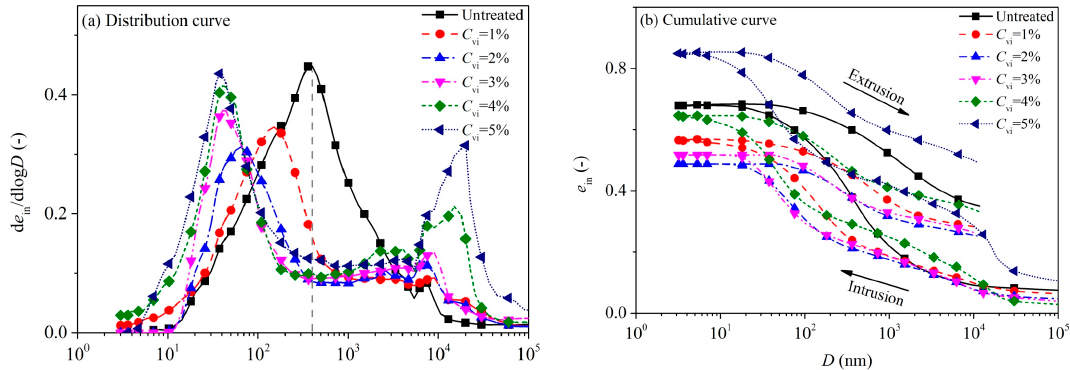
Figure 14. MIP results of saturated untreated and cement-treated GRSs cured to 28 d. The cumulative curves came from the cumulated intrusion volume of the mercury in an intru- sion–extrusion cycle multiplied by the equivalent grain density (i.e., e in = V in × ρ s ) (see Figure 14b). It was assumed that the mercury was retained in the macro-pores after the intrusion pressure was removed [32,33]. Therefore, the macro-void ratio (ratio of the volume of macro-pores to the volume of all solid particles, e M ) equals the intruded void ratio after an intrusion–extrusion cycle. In addi- tion, the maximum e in was identified and adopted as the intruded void ratio of the specimen ( e in ). The micro-void ratio (ratio of the volume of micro-pores to the volume of all solid particles, e m ) is the difference between the void ratio ( e ) of the specimen and the macro-void ratio (i.e., e m = e − e M ). As the void ratio of the specimen may change during curing, the exact micro-void ratio cannot be determined based on the initial void ratio ( e 0 ). Figure 15 illustrates the delimitation of the macro- and micro-pores for the saturated untreated specimens as an example. The e in and e M of the speci- mens were determined based on this criterion, and the dependences of e 0 , e in , and e M on the cement content are shown in Figure 16. The e in and e M were observed to decrease with the cement content in the range of C vi ≤ 2%, and these tendencies reversed as the cement content further increased. For the untreated specimen, the e in equals the e 0 , indicating no changes in the void ratio during confined wetting; this allows the e M and e m of the untreated specimen to be determined (giving e M = 0.35 and e m = 0.33). For the treated specimens, the differences between the e in and e 0 are the combined effects of the formation of C–S–H and aggregates. The detailed mechanisms are discussed and the void ratios of the cured specimens are estimated in Section 4.3. Figure 15. Delimitation of macro- and micro-pores in saturated untreated GRS based on results of an intrusion–extrusion cycle.